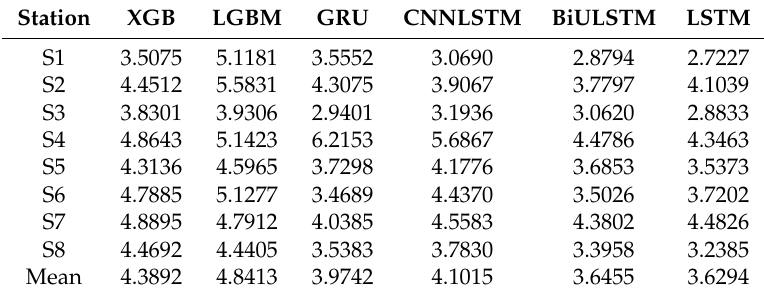
Table A1. Models results for MAE (µg/m 3 ).